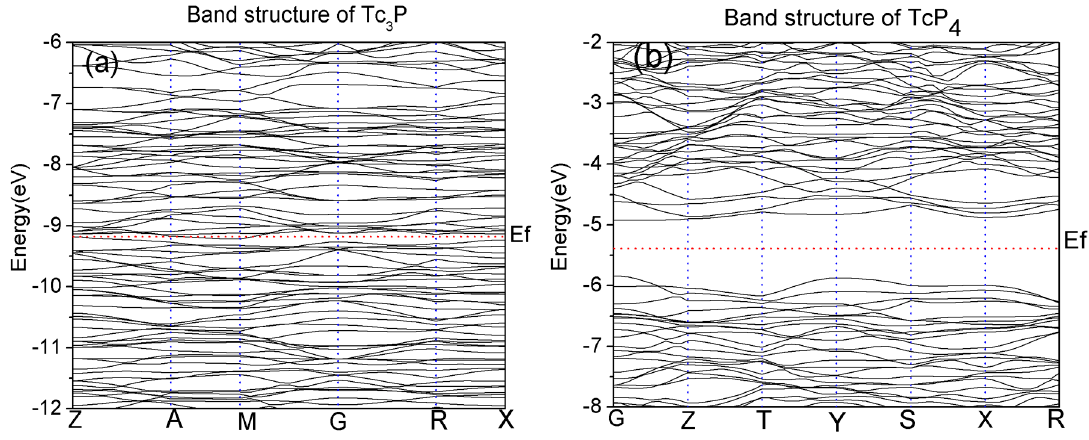
Figure 1. Electronic band structures of the ( a ) Tc 3 P and ( b ) TcP 4 crystals in the vicinity of the Fermi level. The red horizontal dotted lines correspond to the Fermi level E f .